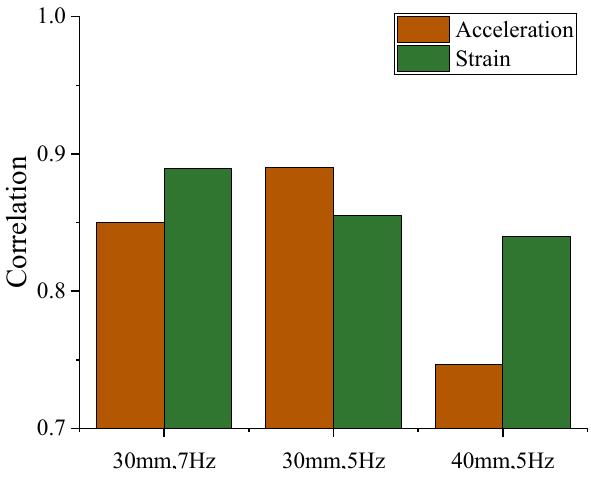
Figure 12. Data correlation coefficients of acceleration and strain between test and simulation under different parameter combinations.